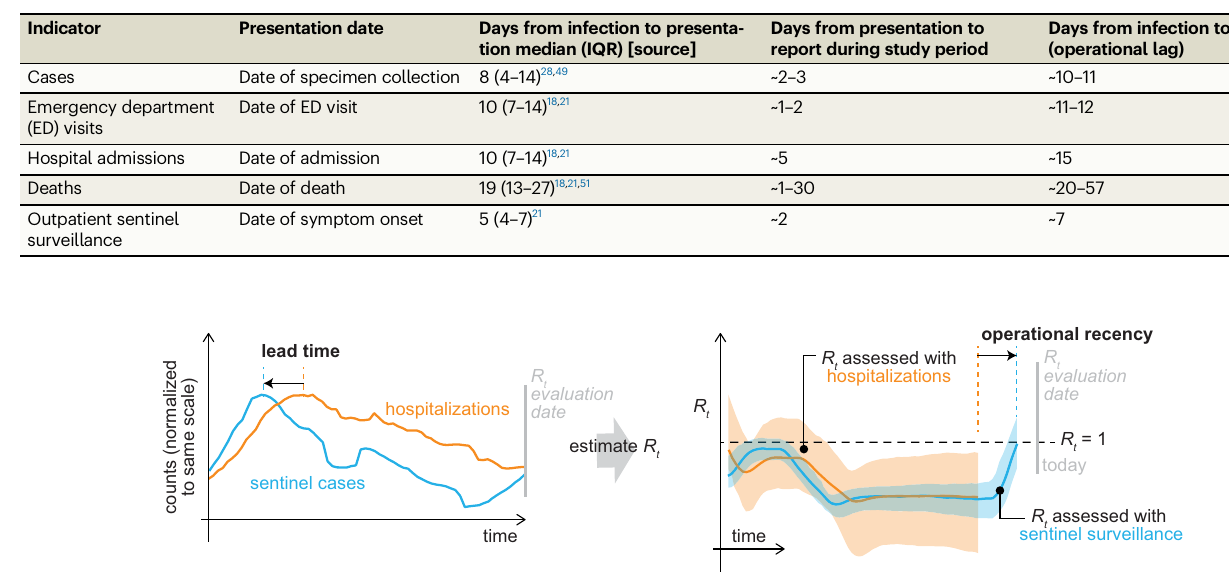
Table 1 | Delays associated with each indicator traditionally used for SARS-CoV-2 surveillance and the theoretical operational recency provided by outpatient sentinel surveillance